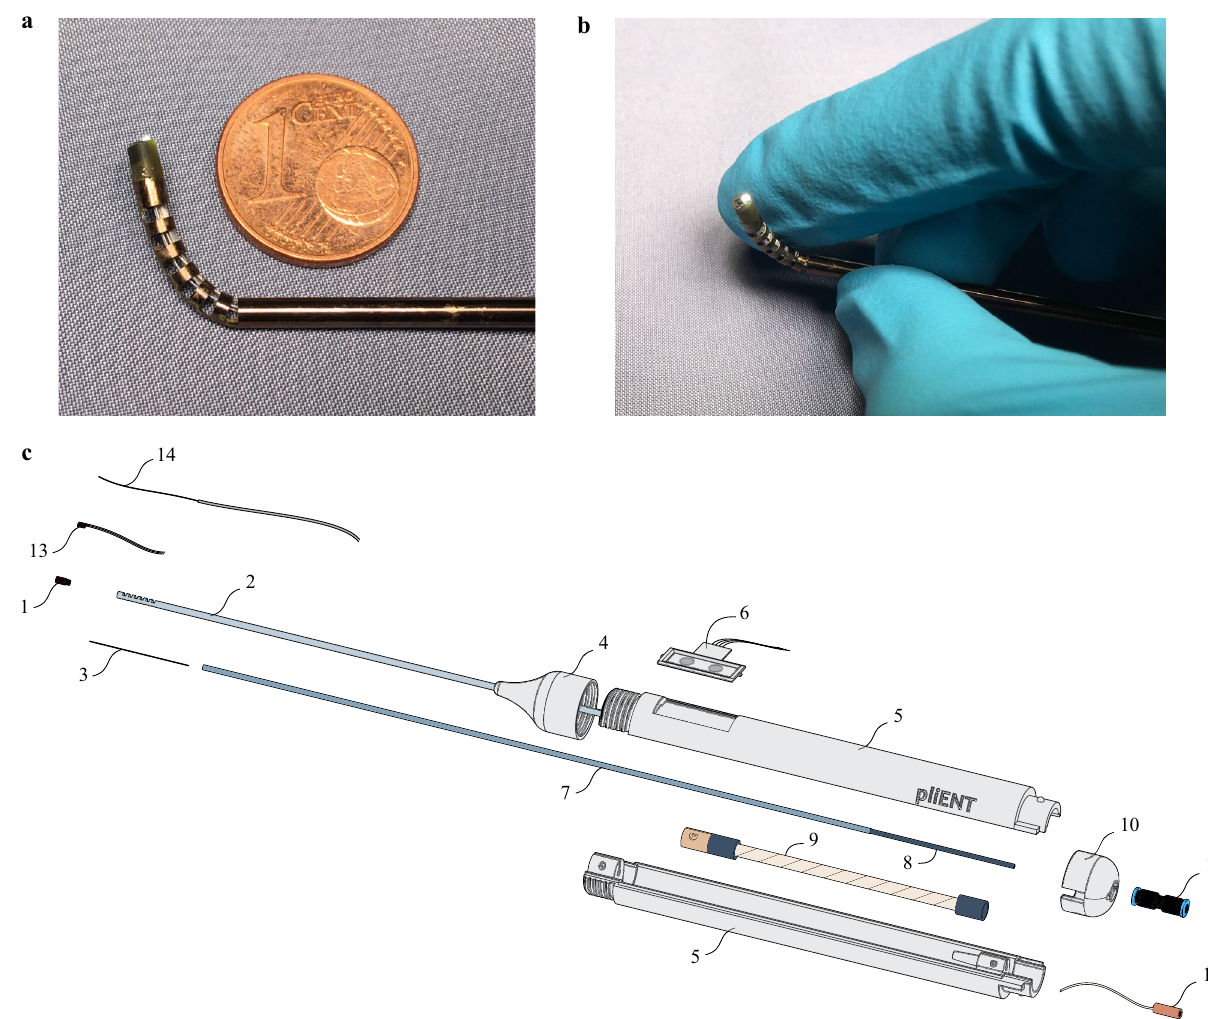
Figure 2. Flexible endoscope for maxillary sinus inspection. ( a ), view of the bending capabilities of the 2.3 mm diameter endoscope; ( b ), detail of the endoscope distal tip with camera and illumination; ( c ), overview of the different components of the single-handed, flexible, steerable endoscope for maxillary sinus surgery. 1. tip; 2. NiTi shaft; 3. cable ; 4. screw-on cap; 5. two-parts-handle; 6. button interface; 7. mobile outer tube of the concentric muscle; 8. fixed inner tube of the concentric muscle; 9. McKibben muscle; 10. plug-on cap; 11. pressure source connector; 12. pressure source tube; 13. chip-on-tip camera; 14. light